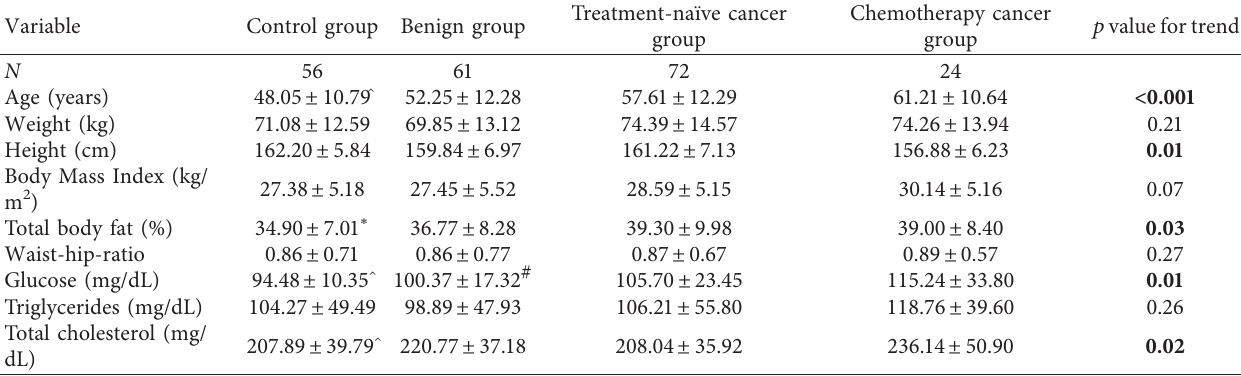
Table 1: Descriptive characteristics of the study variables and unadjusted case-control comparisons.